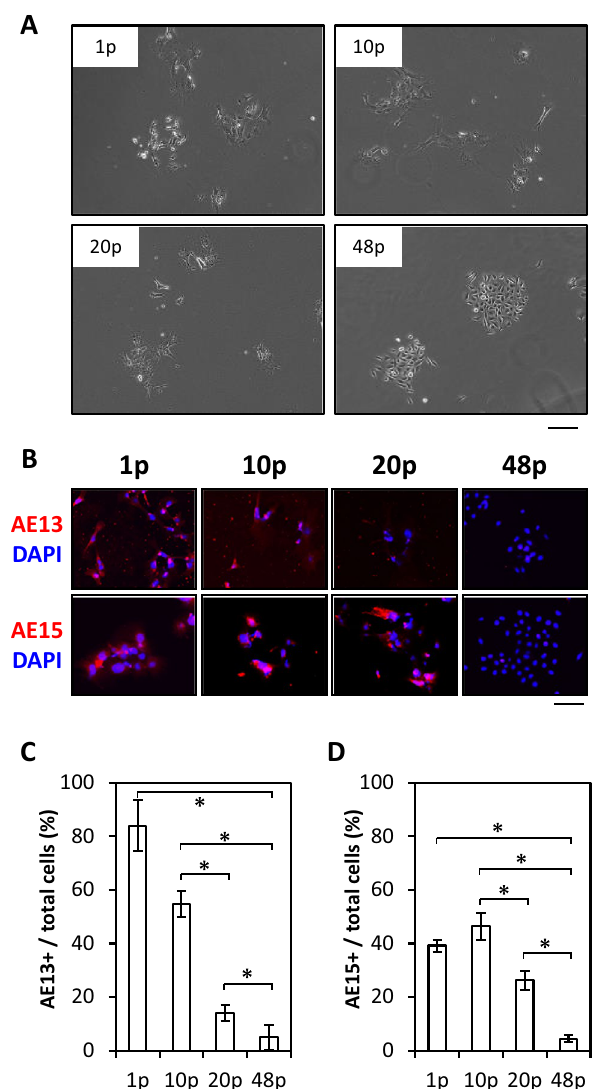
Figure 5. Lost differentiation ability of HFSCs during long-term culture with M-CnT. ( A ) Morphology results of 1p-, 10p-, 20p-, and 48p-HFSCs cultured with M-CnT and treated with Wnt-10b. Scale bar = 40 mm. ( B ) Immunocytochemical results obtained using AE13 and AE15, markers of cell differentiation, for 1p-, 10p-, 20p-, and 48p-HFSCs cultured with M-CnT and treated with Wnt-10b. Scale bar = 40 mm. ( C ), ( D ) Percentages of AE13- ( C ) and AE15-immunopositive ( D ) cells in 1p-, 10p-, 20p-, and 48p-HFSCs cultured with M-CnT. * p <